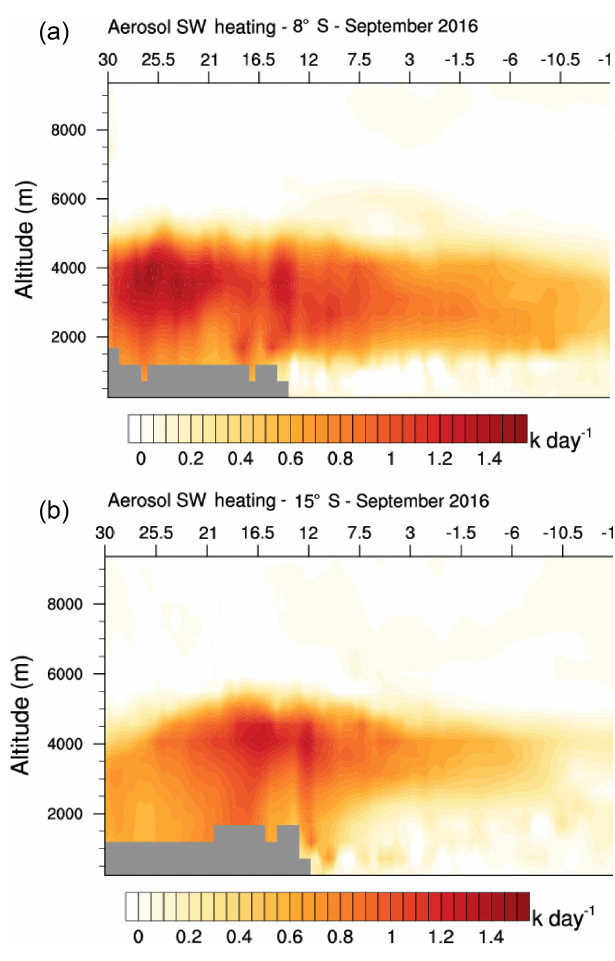
Figure 10. Monthly mean (September 2016) aerosol SW heating rate vertical profiles simulated by the ALADIN-Climate model for two transects at latitudes of 8 (a) and 15 ◦ S (b) . Longitudes are be- tween 30 ◦ E and 11.5 ◦